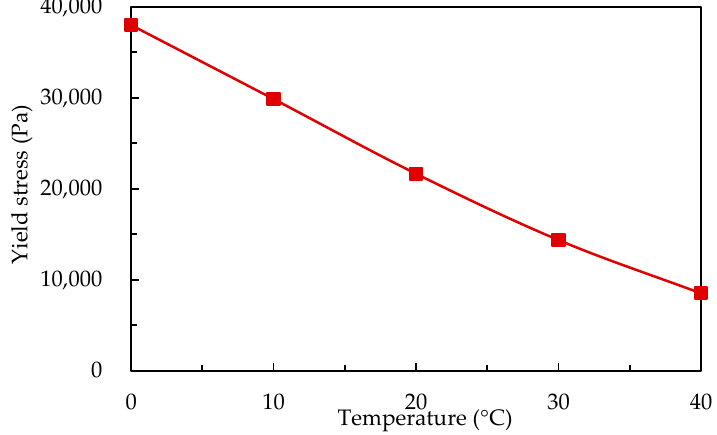
Figure 5. Relationship between the wax sample yield stress and temperature.